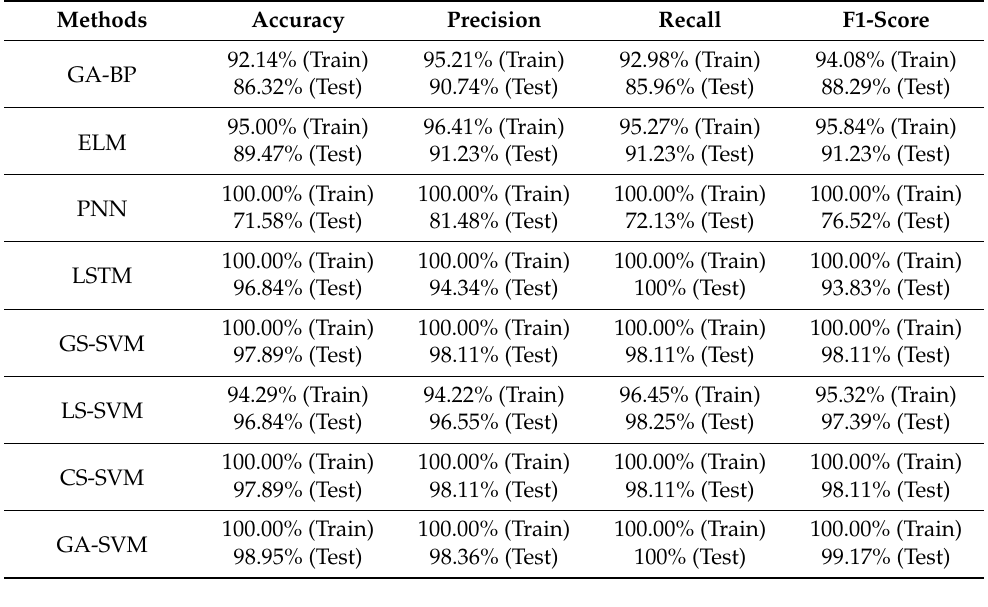
Table 4. Results of model evaluation indicators for machine learning classifiers.